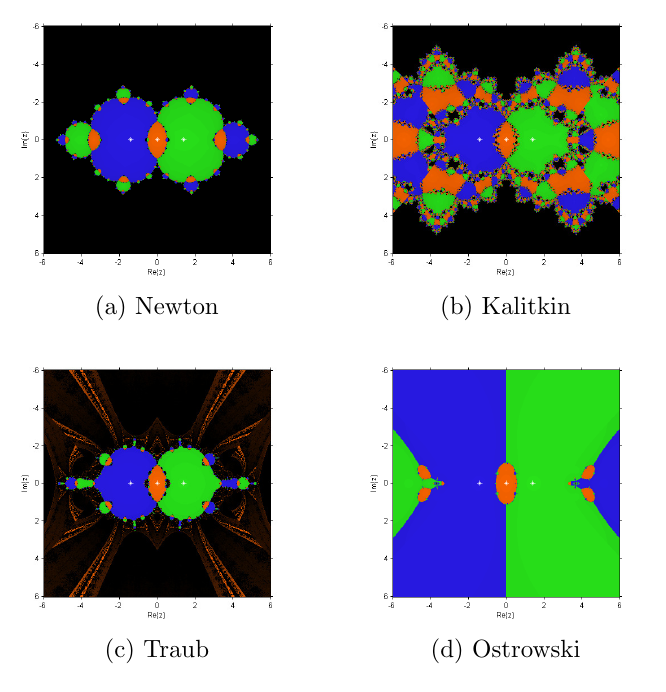
Figure 1. Dynamical planes of f ( x ) = arctan( x ) − 2 x